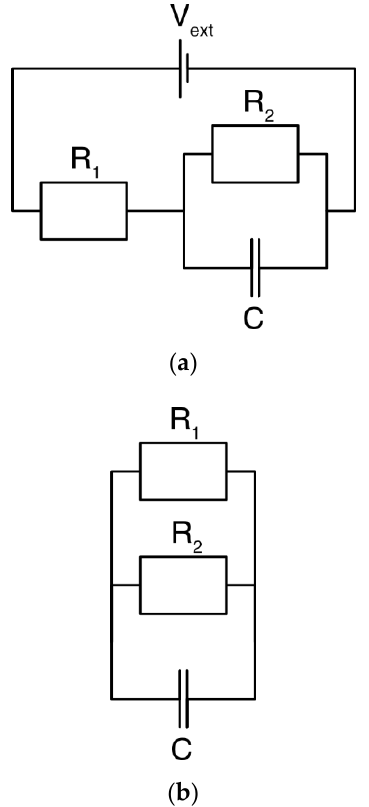
Figure 3. A simple circuit for describing the dynamics of a charging electrode. ( a ) During charging, the capacitive element 𝐶 relates to how much charge can be stored, the series resistance 𝑅 1 governs the rate of the current, and the resistance 𝑅 2 determines the charge leakage. 𝑉 𝑒𝑥𝑡 is the applied voltage. ( b ) When the voltage is removed, the capacitive element acts as a battery, and the stored charge is released. The charge can be released either through the external circuit ( 𝑅 1 ) or as leakage current through the resistive element ( 𝑅 2 ).